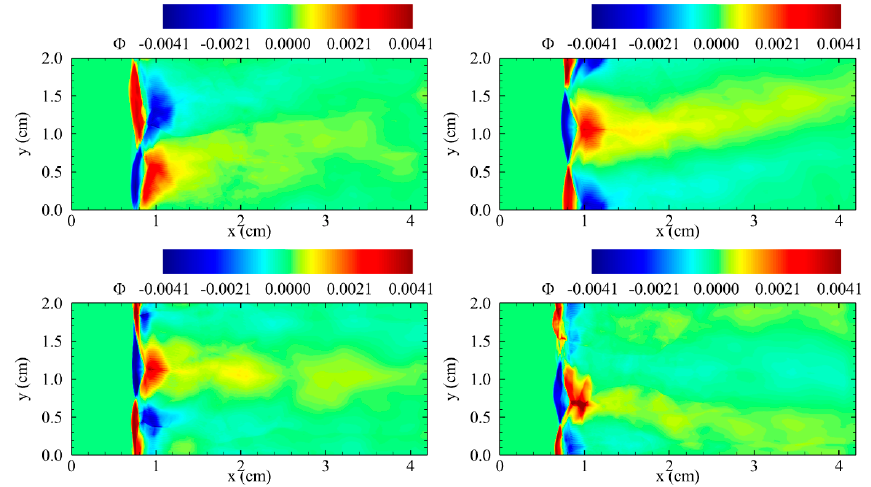
Figure 19. Primary DMD modes of the divided region; part 1-top left, part 2-top right, part 3-bottom left, part 4-bottom right.